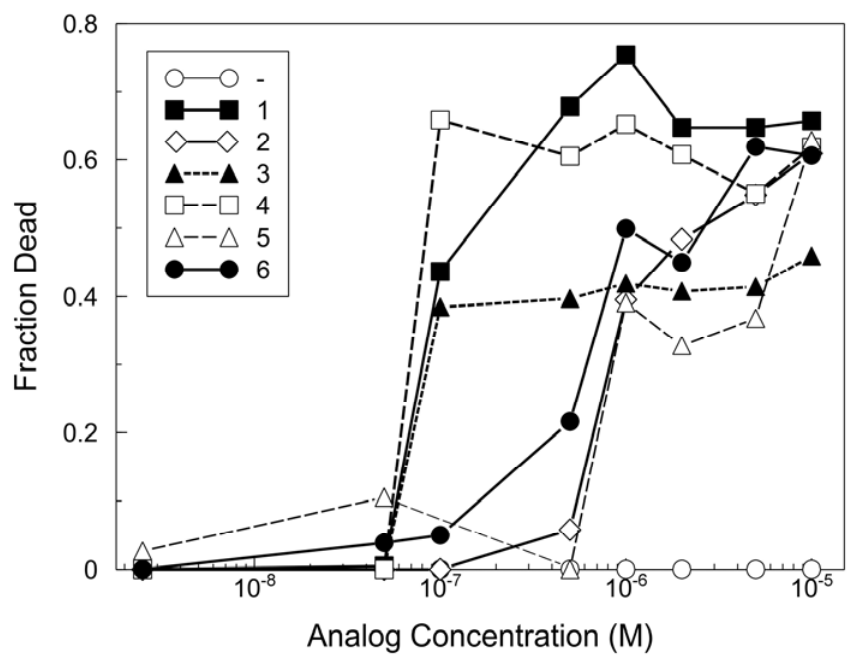
Figure 3. Comparison of MG analog toxicities for mammalian